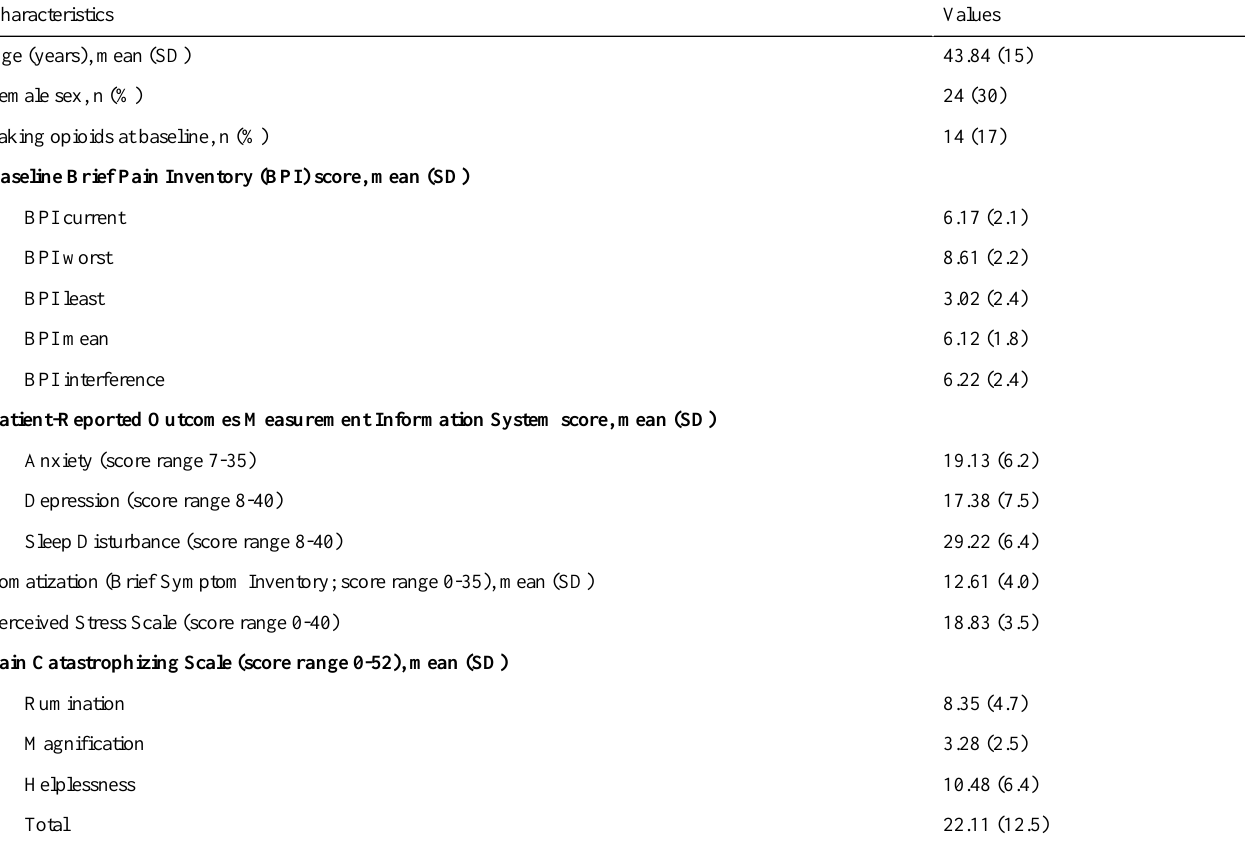
Table 1. Patient sample characteristics